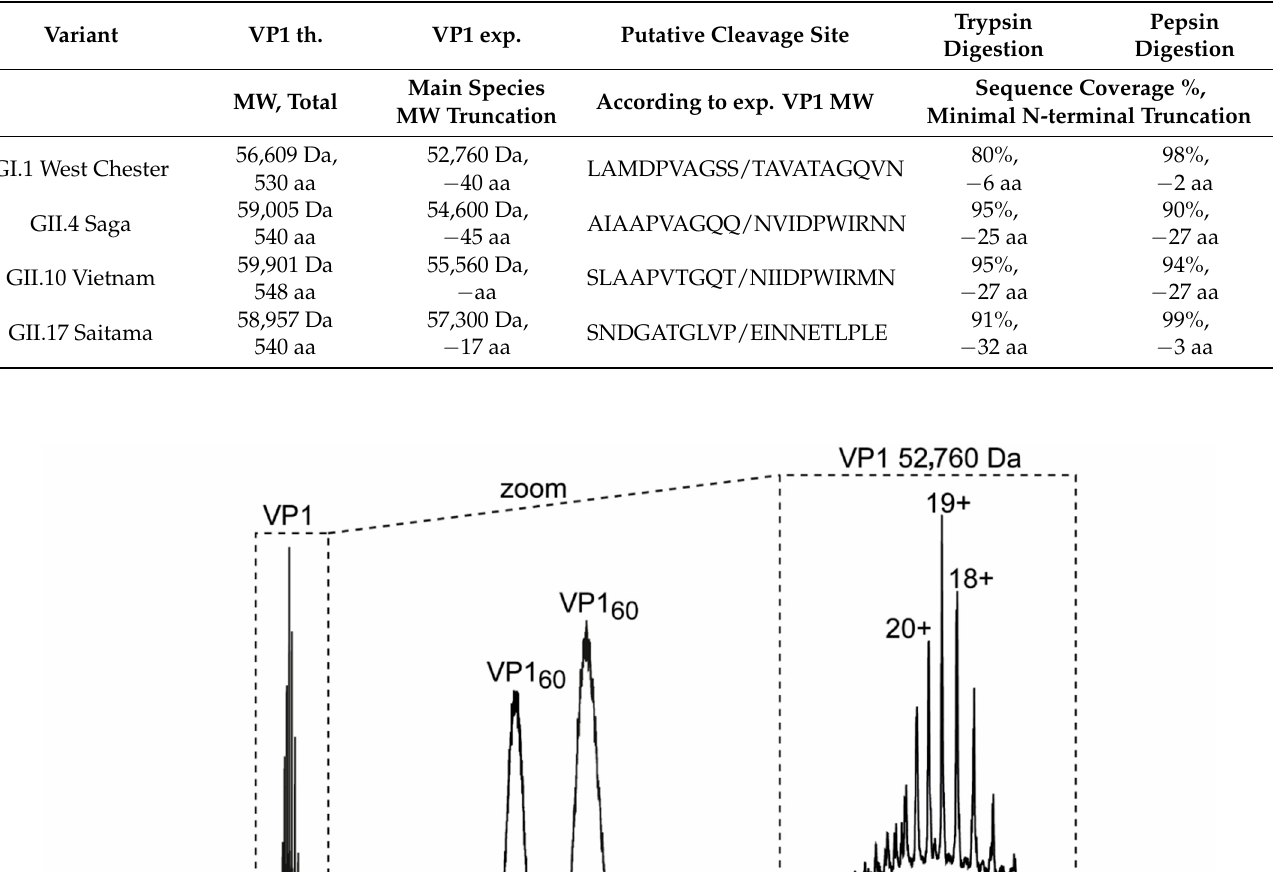
Table 1. Overview of investigated samples forming mainly T = 1 particles. Theoretical (th.) VP1 mass and amino acid (aa) number given for constructs West Chester, Saga, Vietnam, and Saitama constructs. Experimental (exp) mass and truncation given for main observed monomeric species after dissociation in conventional MS for all variants except GII.17 Saitama. For Saitama, mass was